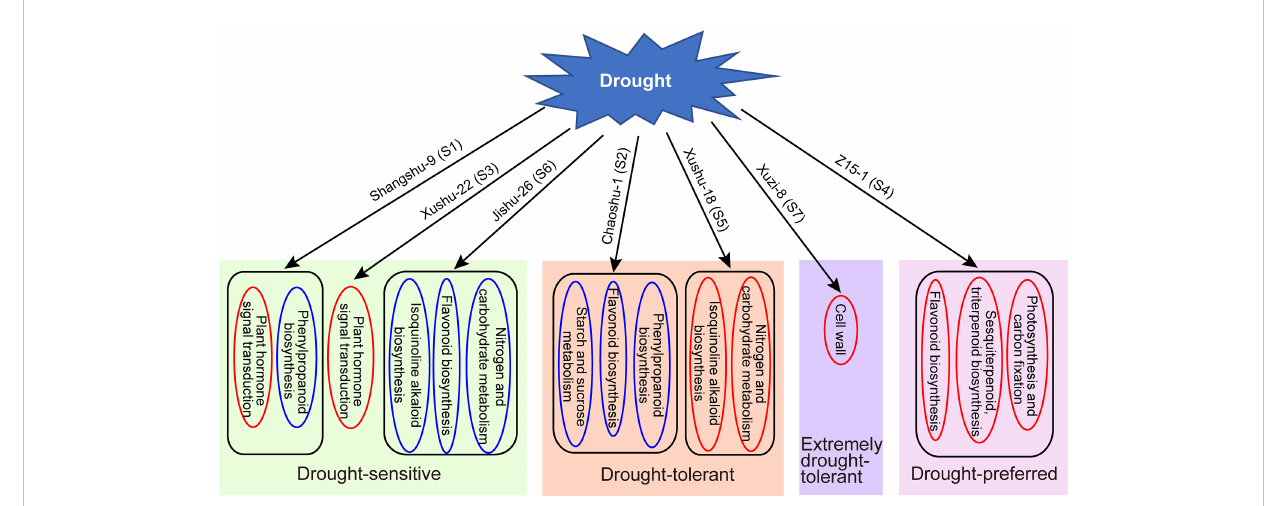
FIGURE 8 A corresponding working model of different drought tolerant sweet potato clutivars in response to drought. Red box indicate up-regulation, blue box indicate